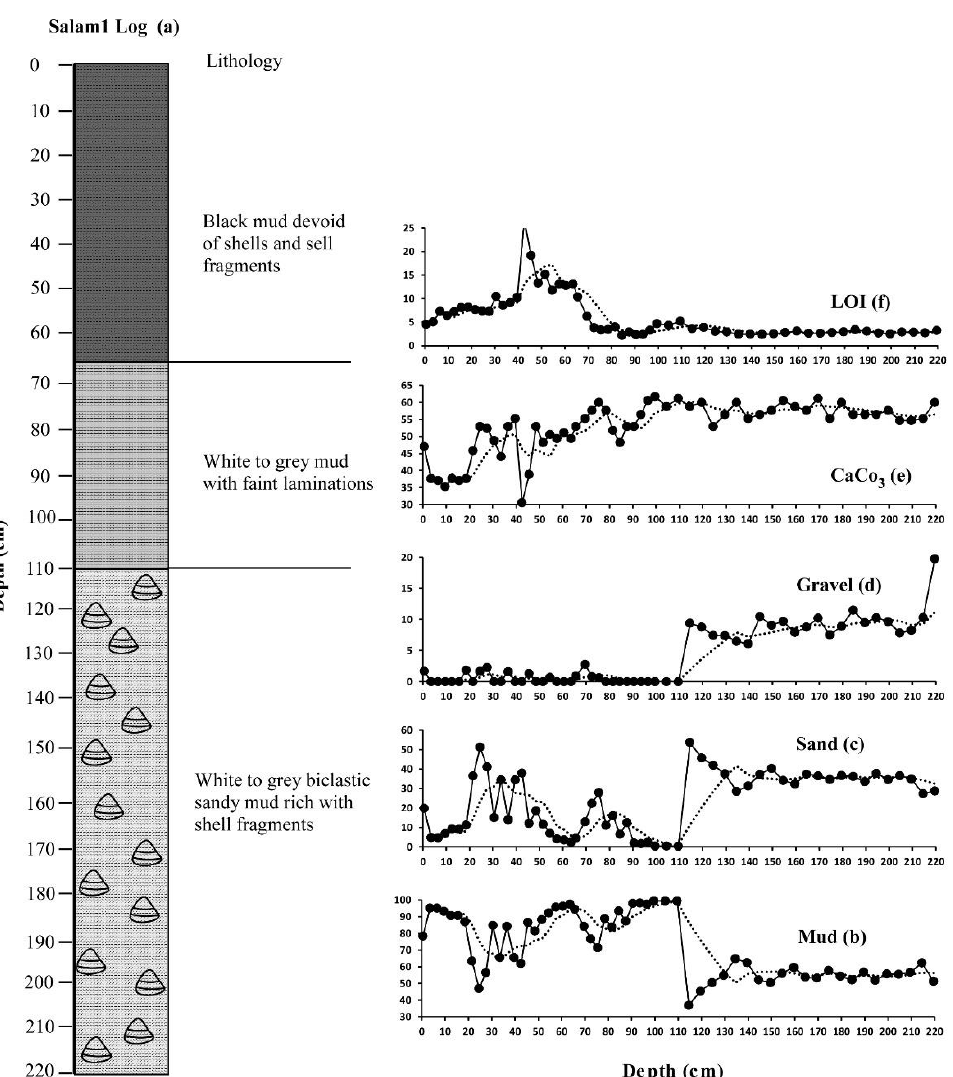
Figure 2. ( a ) Lithologic of the Salam1 sedimentary record, ( b – f ) Mud, sand, gravel, LOI%, and CaCO 3 % distribution in the Salam1 core from Al-Salam Lagoon, the Jeddah coast, Saudi Arabia. (Trend line of 5 average is shown by dots).